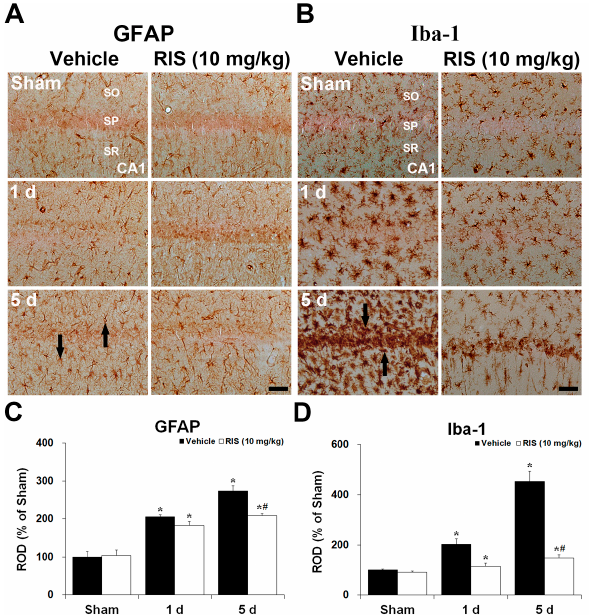
Figure 2. E ff ects of RIS on GFAP + astrocytes ( A ) and Iba-1 + microglia ( B ) in the CA1 after TI under UBT condition. GFAP + astrocytes (arrows in ( A )) and Iba-1 + microglia (arrows in ( B )) are markedly increased in the TI + vehicle group 5 days after TI; however, their immunoreactivity in the TI + RIS group is significantly lower than that in the TI + vehicle group. SO, stratum oriens; SP, stratum pyramidale; SR, stratum radiatum. Scale bar = 50 µ m. Quantitative analyses of GFAP + ( C ) and Iba-1 + cells ( D ). The bars indicate the means ± SEM, n = 7 / group, two-way analysis of variance (ANOVA) with a post-hoc Bonferroni’s multiple comparison test (* p < 0.05 vs. sham + vehicle group; # p < 0.05 vs. TI + vehicle